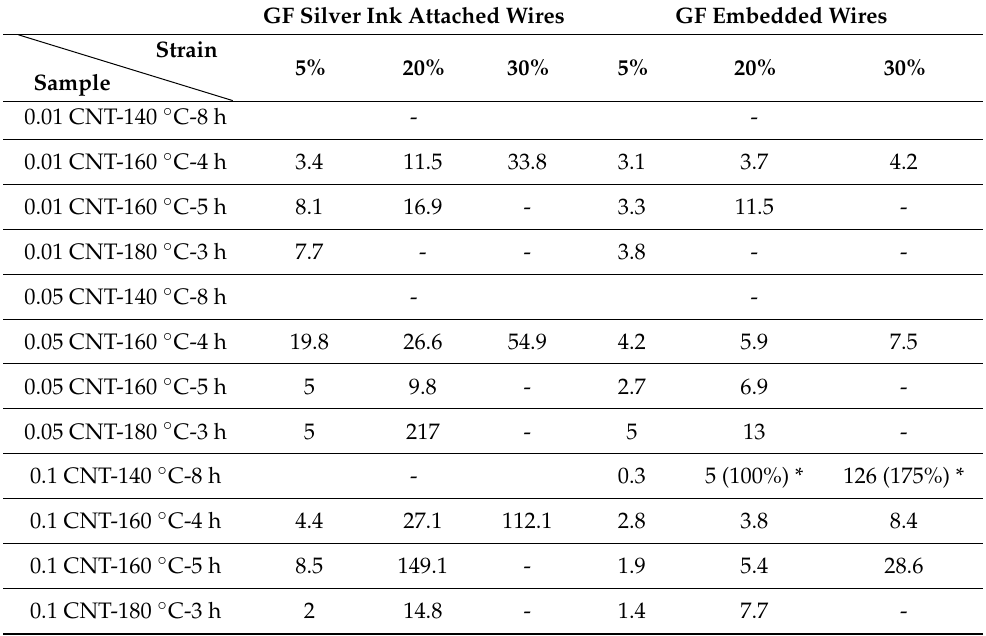
Table 2. GF of the different samples with the two types of electrode’s